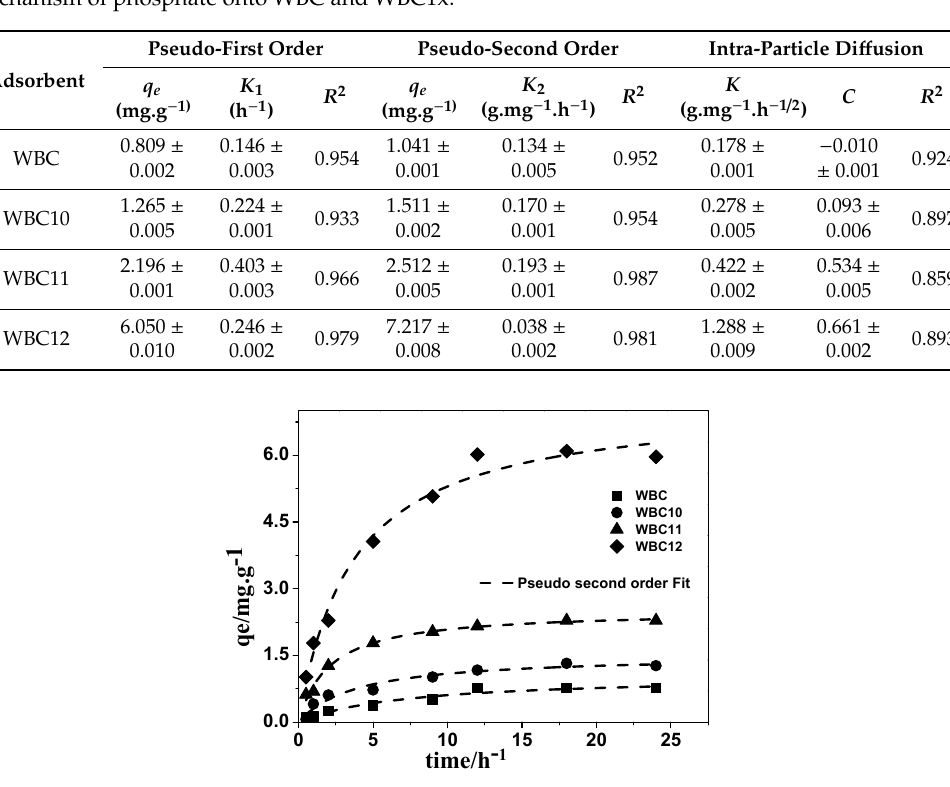
Figure 10. Adsorption kinetic and modeling for phosphate onto WBC and WBC1x.